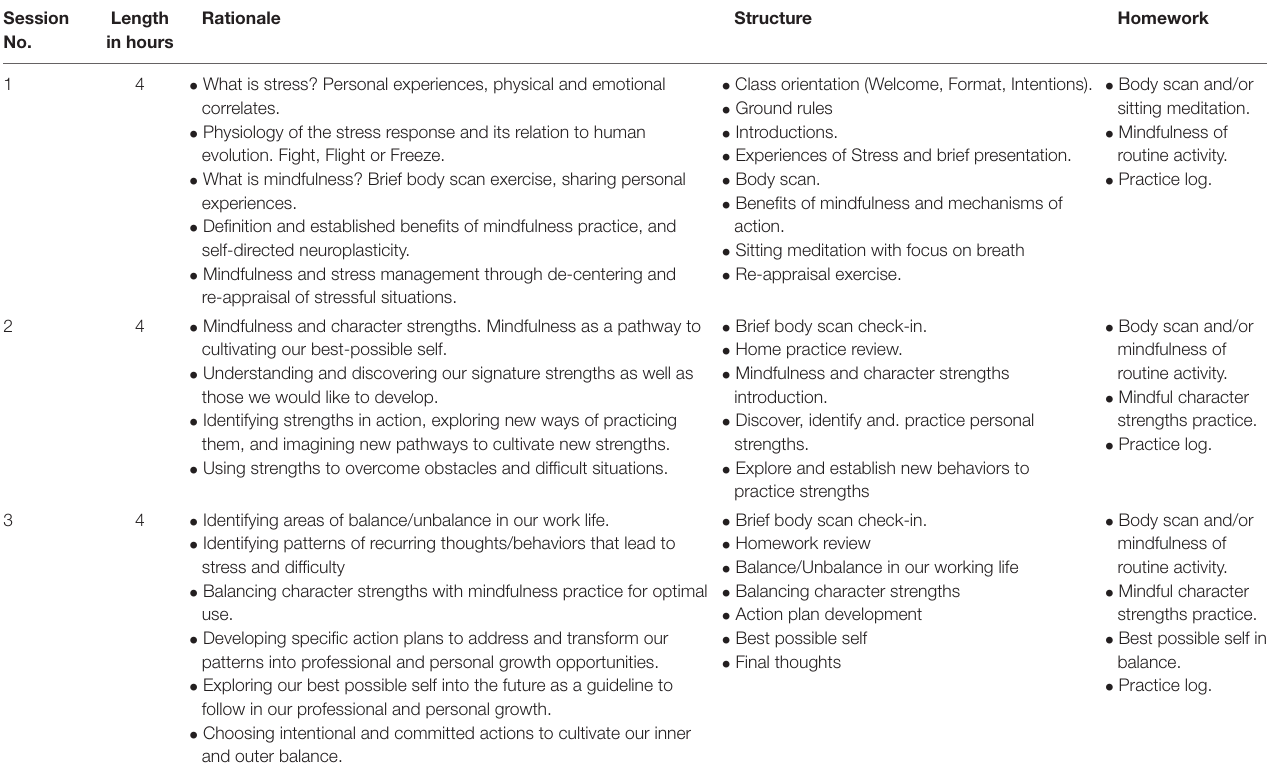
TABLE 1 | MPSM intervention program specific session content and structure. Session